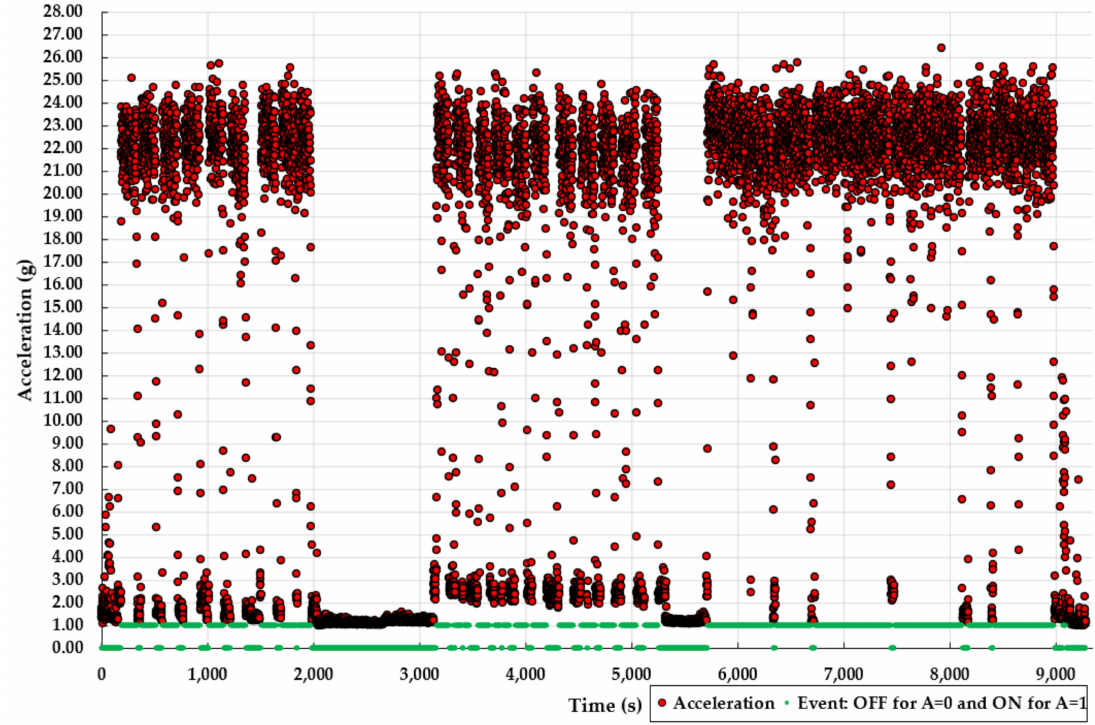
Figure A5. Description of datasets used in the testing phase of the MLPs: TEST_S2. Note: conventionally, a value set at 0 (A = 0) indicates the events documented as OFF, while a value set at 1 (A = 1) indicates the events documented as